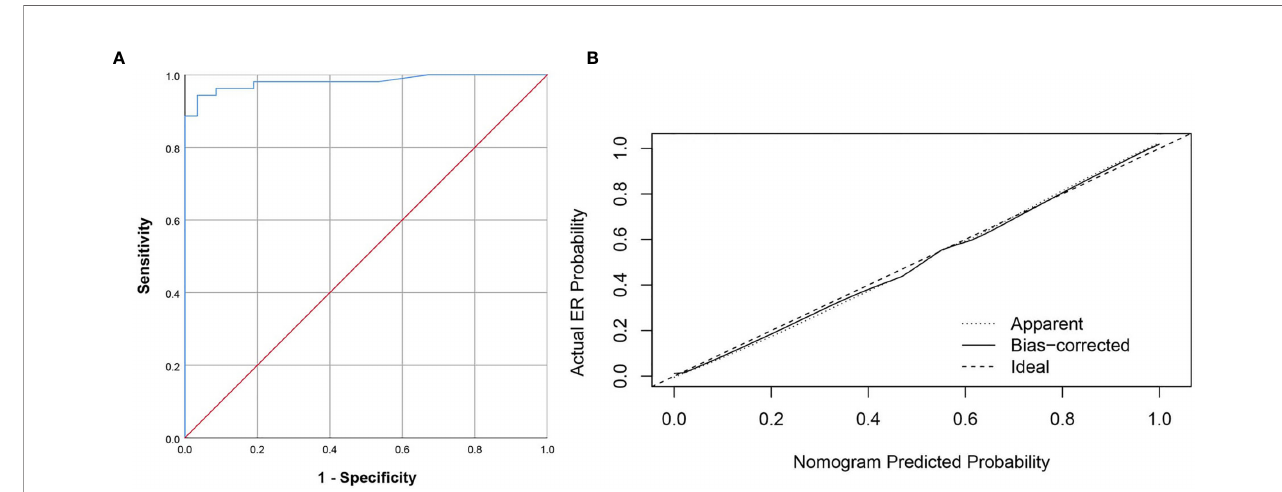
FIGURE 4 | The ROC curve and calibration curves for the radiomics nomogram. (A) Graph shows utility of ROC curve of the radiomics nomogram to discriminate ER and NER of small HCC. (B) Calibration curves for the radiomics nomogram. Calibration curves indicate the goodness-of- fi t of the nomogram. The closer the full line approaches the ideal prediction line, the better the predictive ef fi cacy of the nomogram.